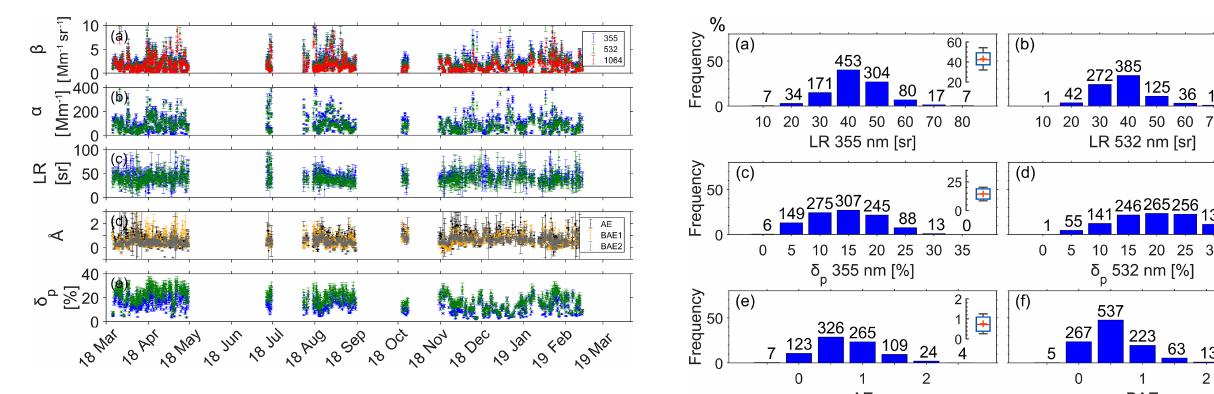
Figure 5. Time series of intensive and extensive aerosol proper- ties at different wavelengths (355nm in blue, 532nm in green, and 1064nm in red). (a) Backscatter coefficient. (b) Extinction co- efficient. (c) Lidar ratio. (d) Ångström exponents (Å) where the extinction-related Ångström exponent (AE) is marked with black dots, the backscatter-related Ångström exponent at 355/532 (BAE1) with orange, and the backscatter-related Ångström exponent at 532/1064 (BAE2) with grey. (e) Linear particle depolarization ra- tio ( δ p ). The values show the mean optical property of the aerosol layer along with 1 standard deviation indicated with the error bars.